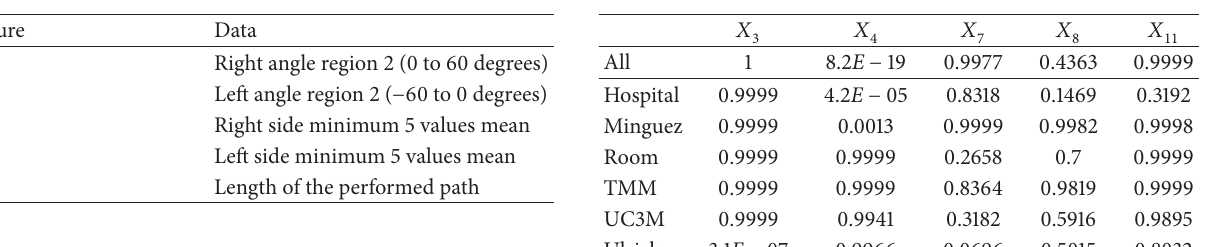
Table 2: Selected features. Table 3: Wilcoxon test